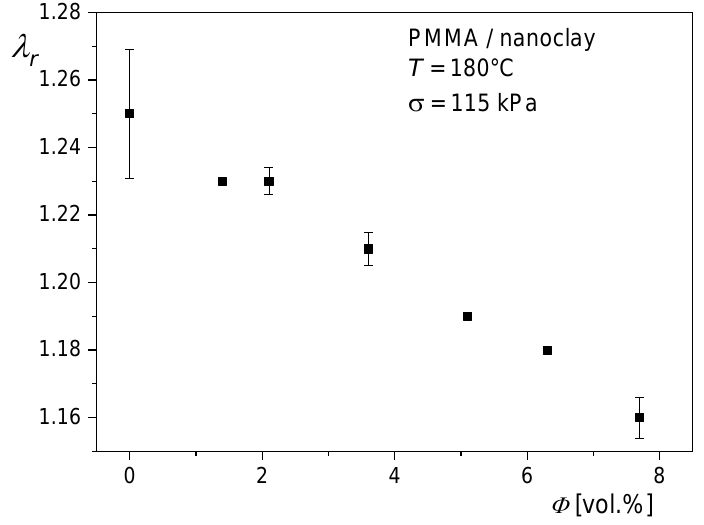
Figure 14. Recoverable stretching ratio λ r = l / l r for the PMMA of Figure 13 as a function of the volume concentration φ of the nanoclay. The experiments were performed at a constant tensile stress of σ = 115 kPa and T = 180 ◦ C. The stretching ratio λ = l / l 0 was 12, before recovery with the initial length of the sample l 0 = 25 mm [29].